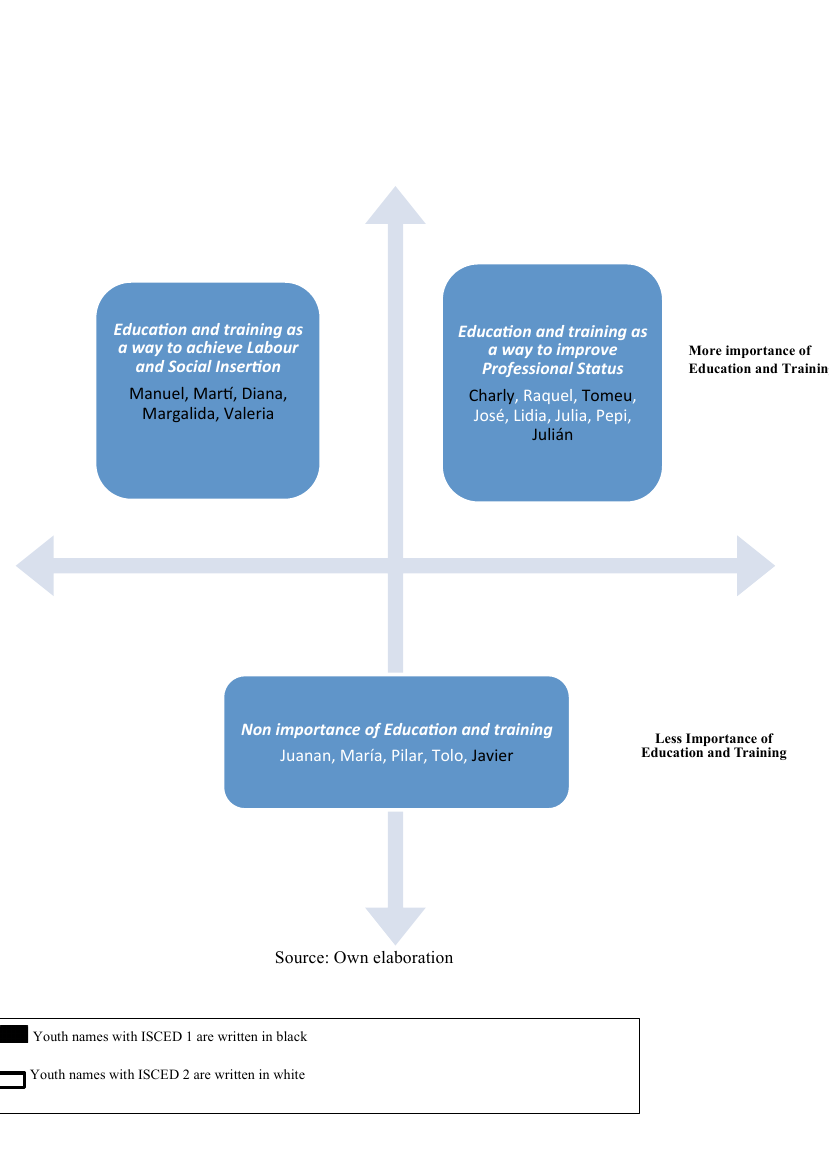
Figure 1 . Typology of pathways according to the importance of education and training and to the goal